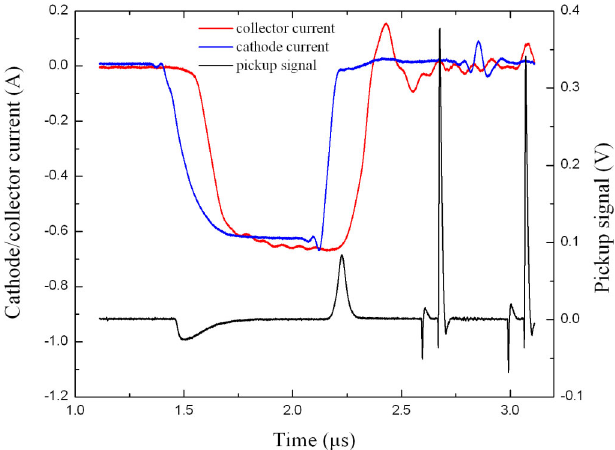
FIG. 22. (Color) BPM pickup signal (black) featuring the elec- tron pulse, two proton (positive peaks), and two antiproton bunches (negative peaks). For clarity the electron pulse is shown timed to the abort gap where no bunches are present. The scope bandwidth was intentionally set to 20 MHz to reject high frequency noise and limit proton bunch signal amplitude. Cathode (blue) and collector (red) currents are measured by current transformers. The artifacts on the right-hand side are caused by the